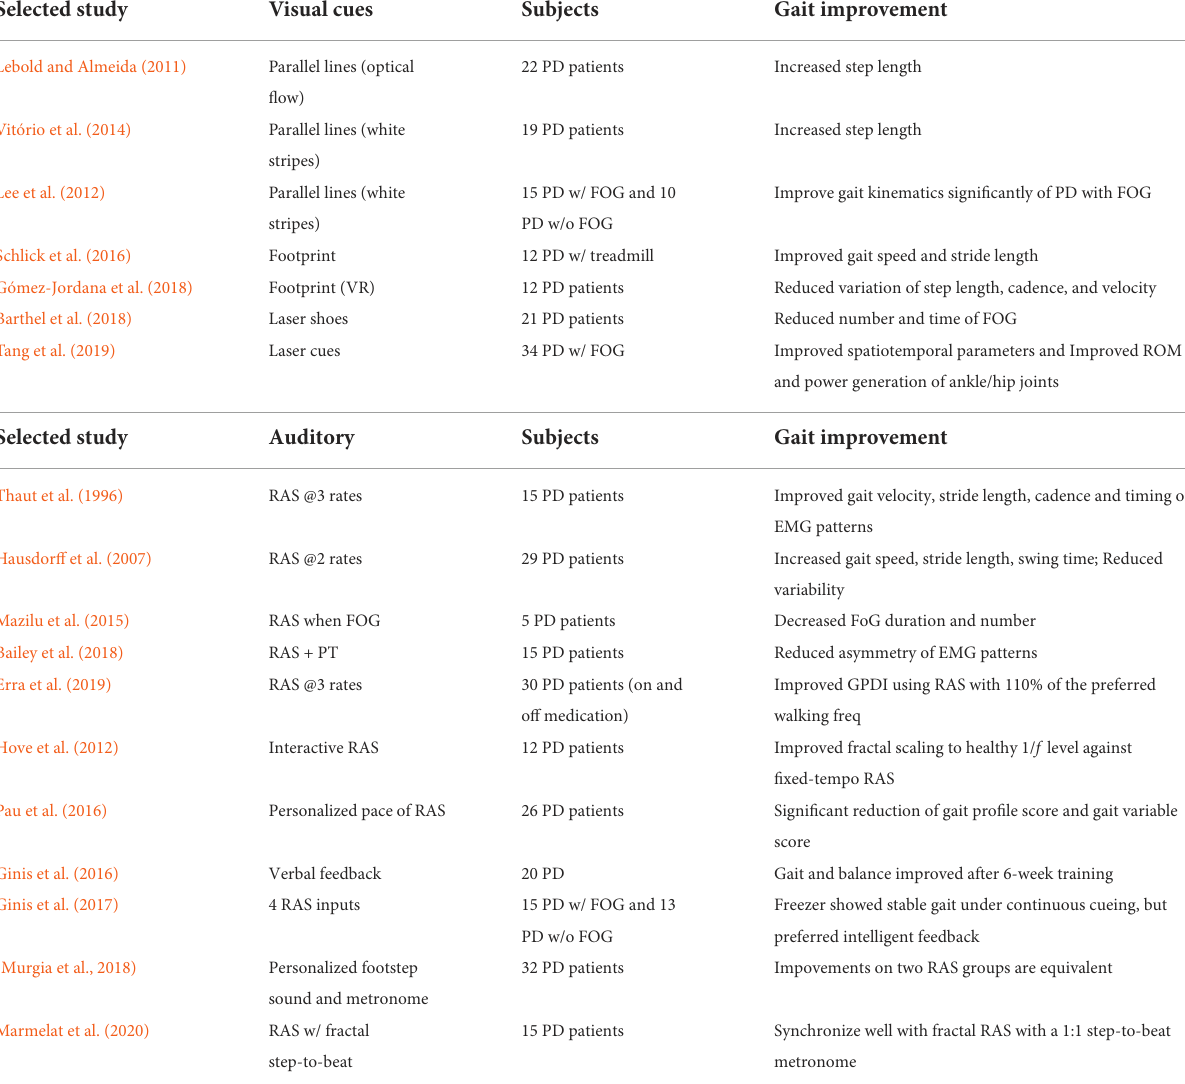
TABLE 7 Common-used visual cues and auditory stimulation for PD gait intervention. Selected